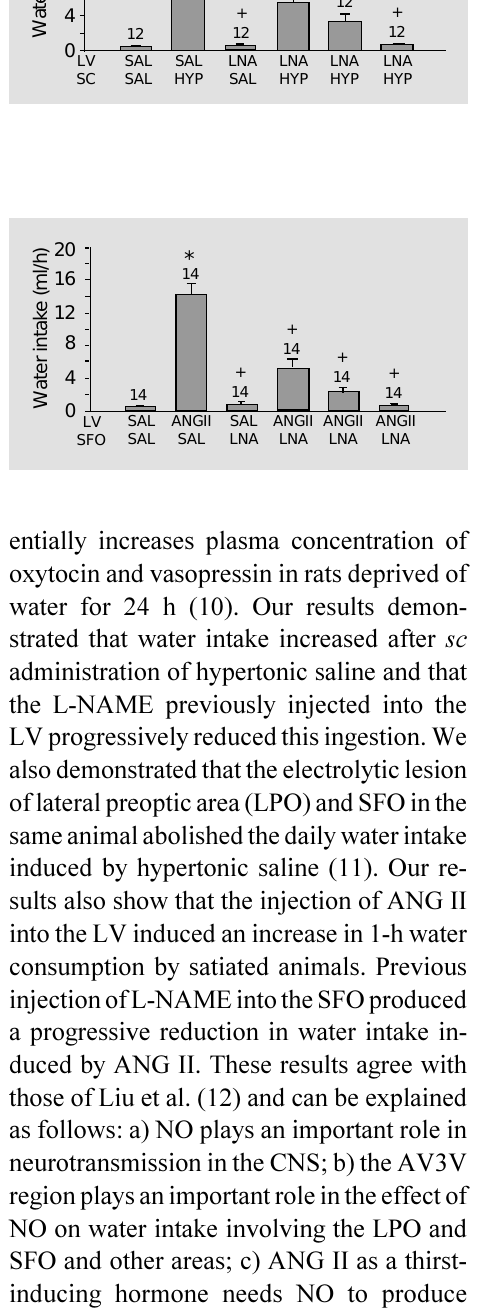
Figure 1 - Water intake after in- jection of saline (SAL) (control - subcutaneous (SC) and lateral ventricle (LV)), hypertonic saline (HYP) (SC) and L-NAME (LNA) (LV). L-NAME was used at the doses of 10, 20 and 40 µg/µl.